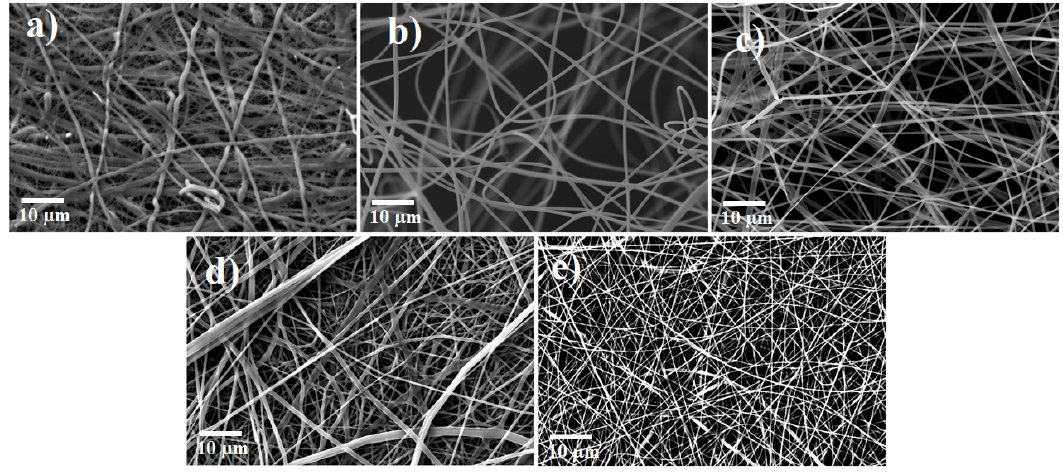
Figure 2 . SEM images of as-spun fibers: ( a ) 0% TiBALDH, ( b ) 10% TiBALDH ( c ) 50% TiBALDH, ( d ) 90% TiBALDH, and ( e ) 100% TiBALDH.